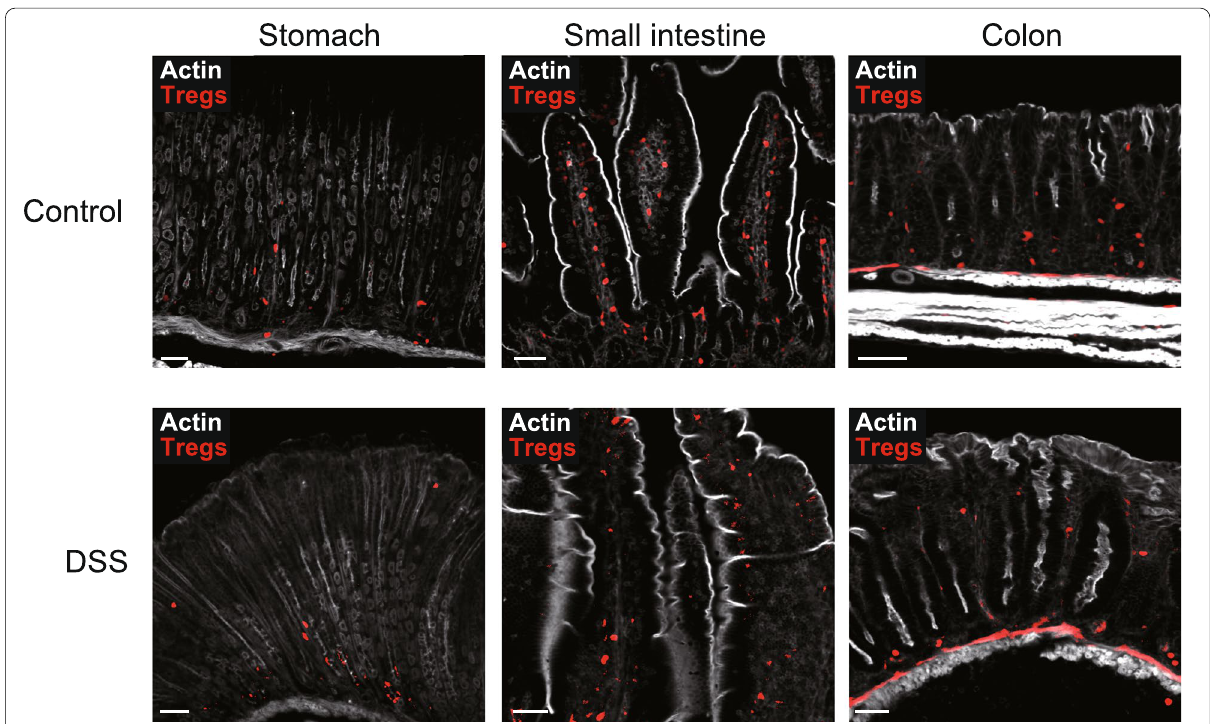
Fig. 3 The distribution of Tregs in the gastrointestinal tract. (upper panel) Localization of tdTomato + Tregs (red) within the stomach (left), small intestine (middle), and colon (right). (lower panel) Localization of tdTomato + Tregs (red) within stomach (left), small intestine (middle), and colon (right) after 7-day DSS administration. Vibratome sections of each tissues from Foxp3 eGFPcreERT2 Rosa26 tdTomato mice were stained with phalloidin to show actin